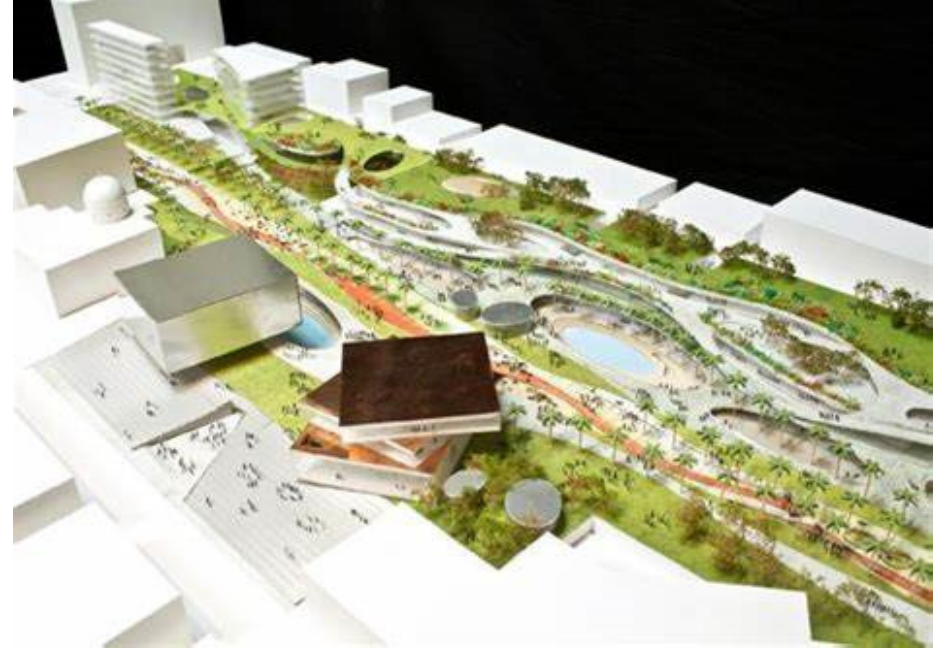
Figure 13. Corso Martiri della Libertà (project in progress).